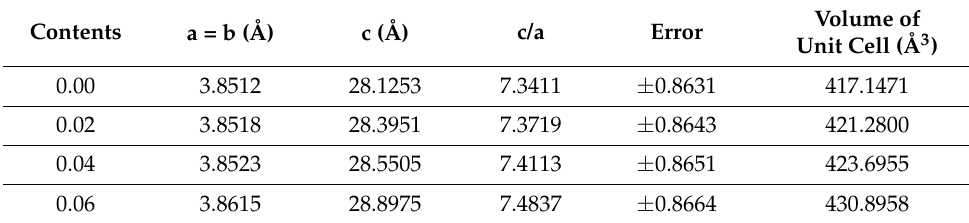
Table 1. Volume and Lattice parameters of Sr n+1 Ti n O 3n+1 (n = 4) sintered ceramics.